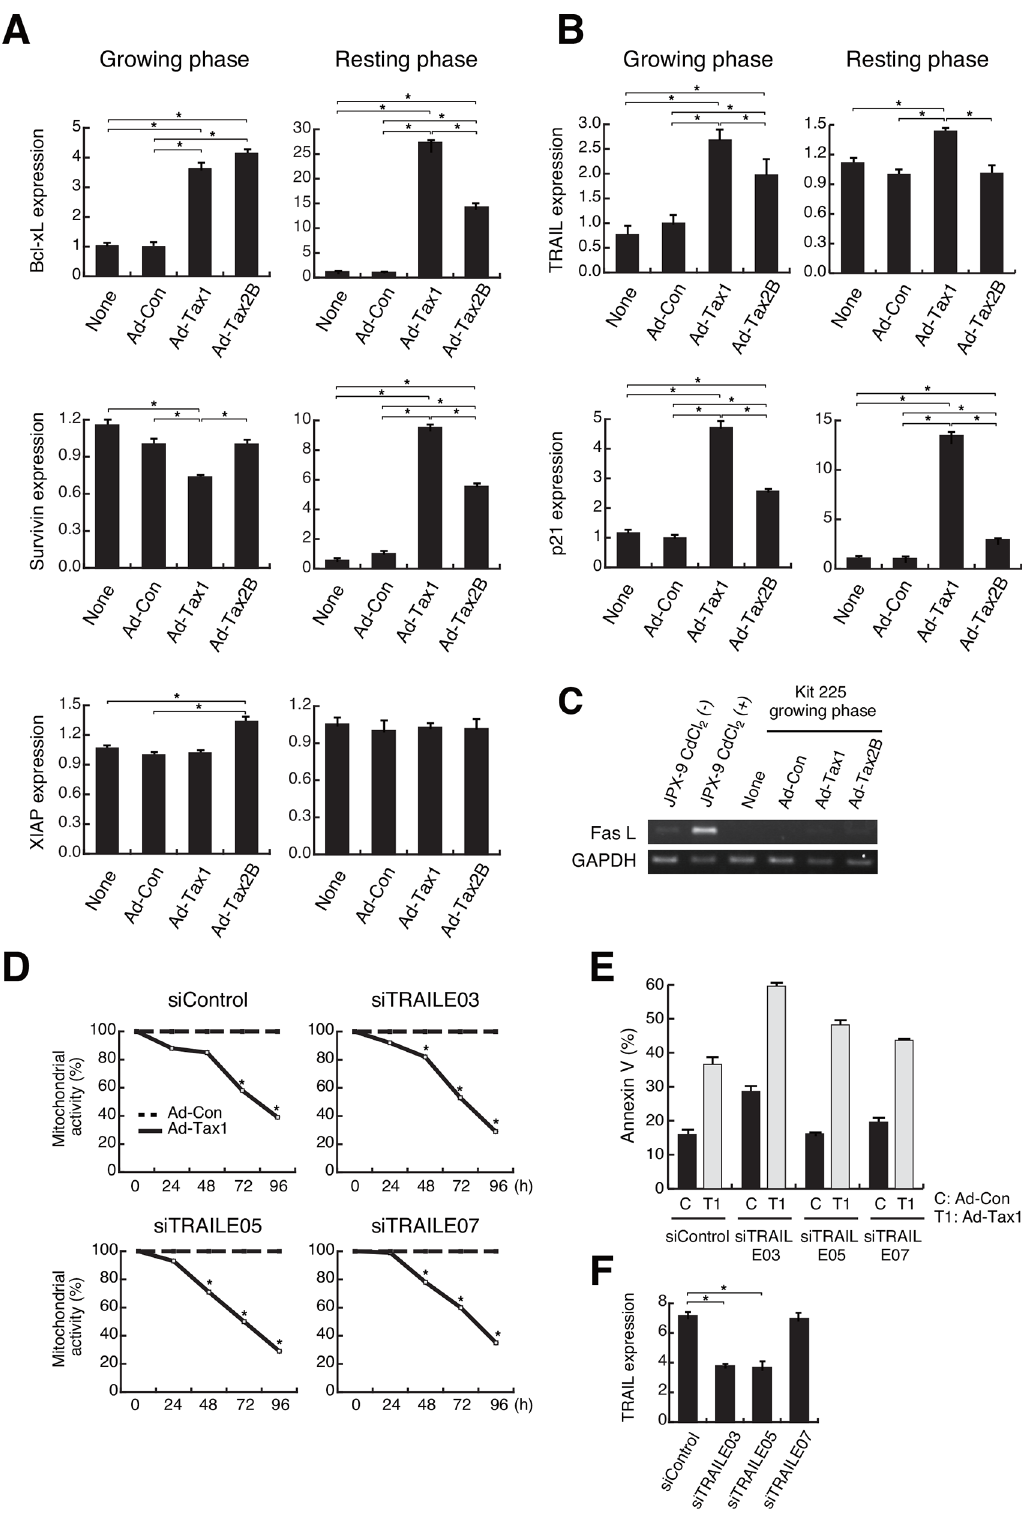
Fig 5. Modulation of apoptosis-related genes by Tax1. (A and B) Growing or resting Kit 225 cells were infected with the recombinant adenoviruses Ad- Tax1 or Ad-Tax2B, and cultured for 72 h. Gene expression was measured by qPCR. Values are shown as the means ± SE. * , p < 0.05. (C) JPX-9 cells were cultured with or without 20 μ M CdCl 2 for 48 h to induce Tax1 expression. Growing Kit 225 cells were infected with Ad-Tax1 and Ad-Tax2B, and cultured for 72